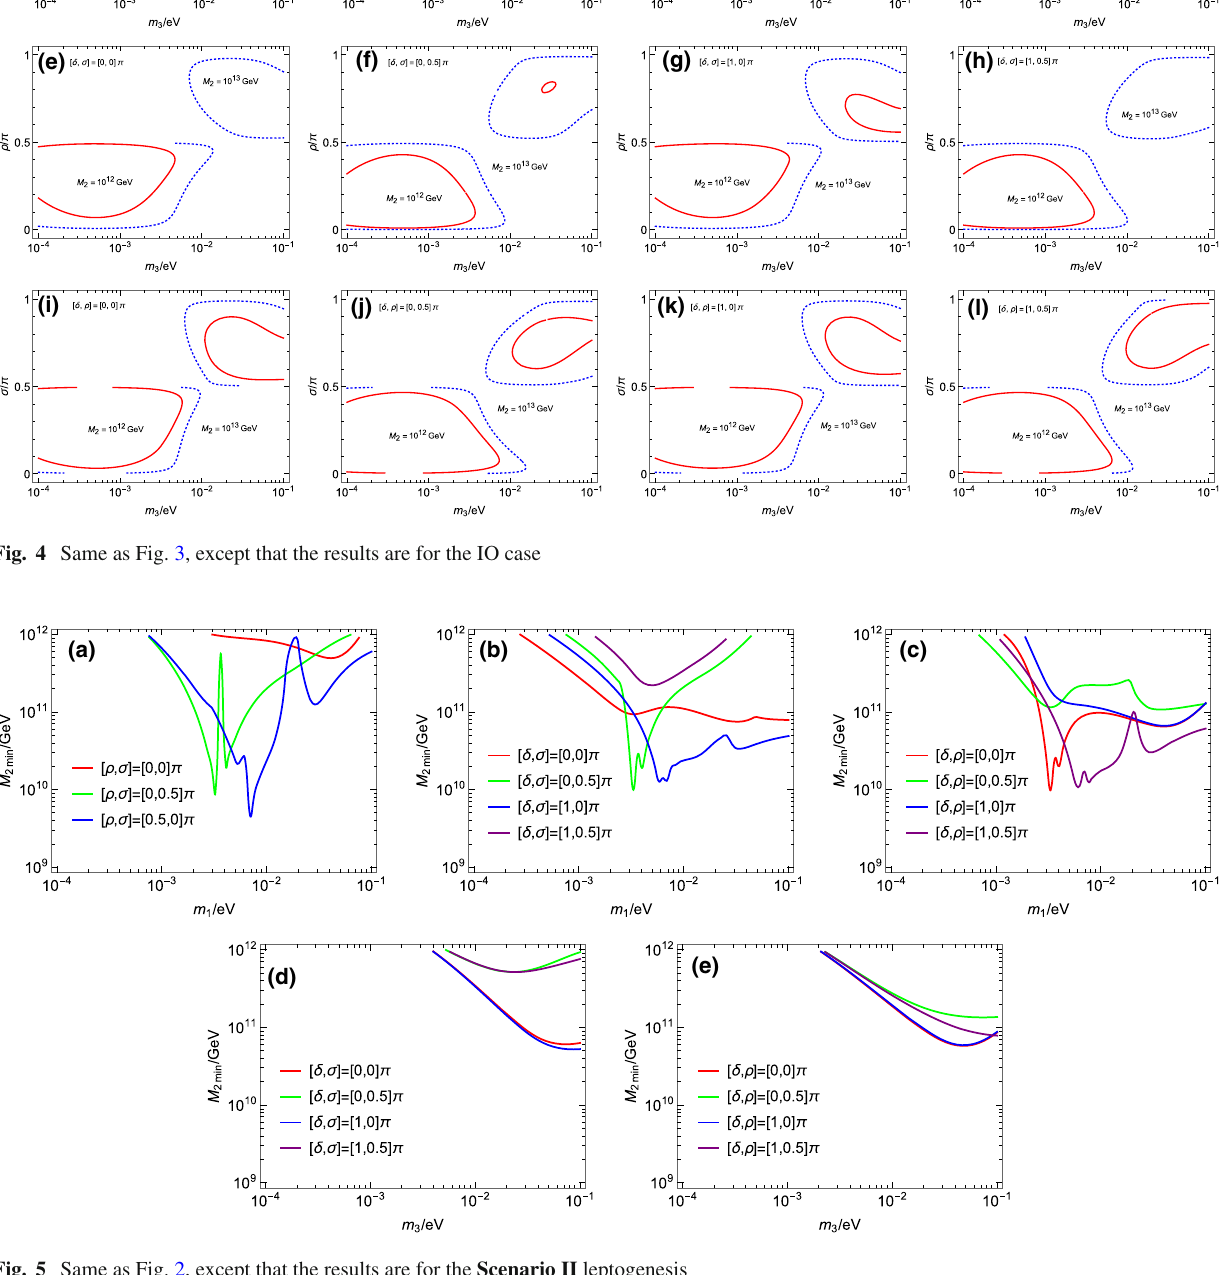
Fig. 5 Same as Fig. 2, except that the results are for the Scenario II